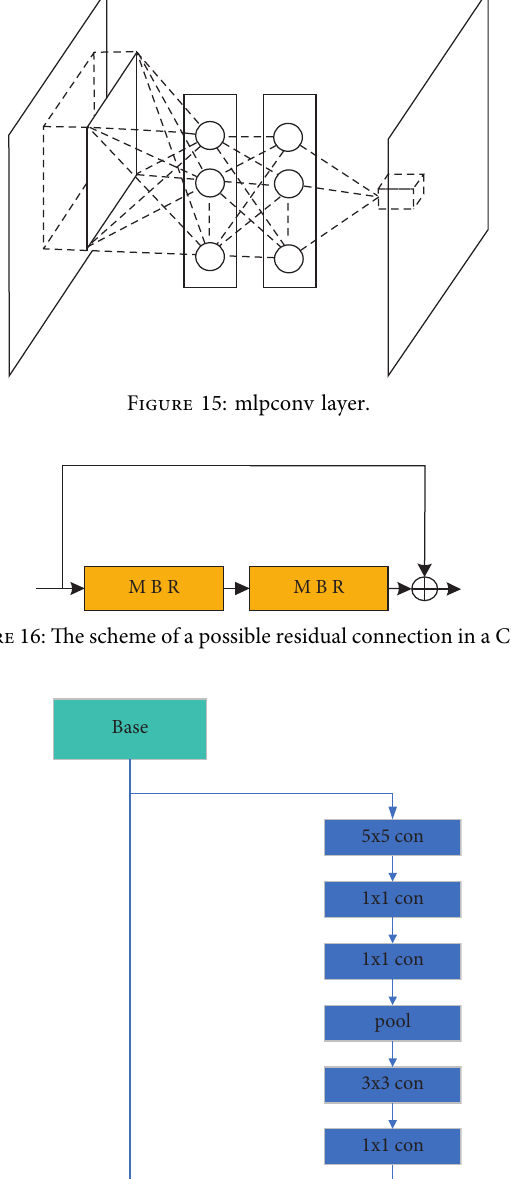
Figure 15: mlpconv